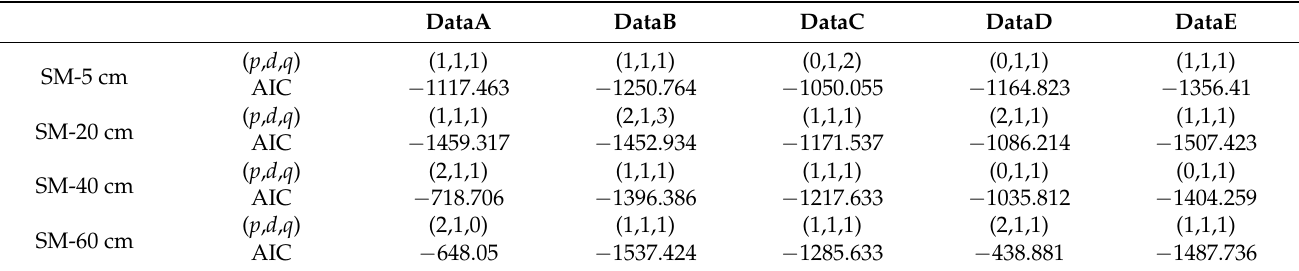
Table 7. DataA~DataE parameters and AIC